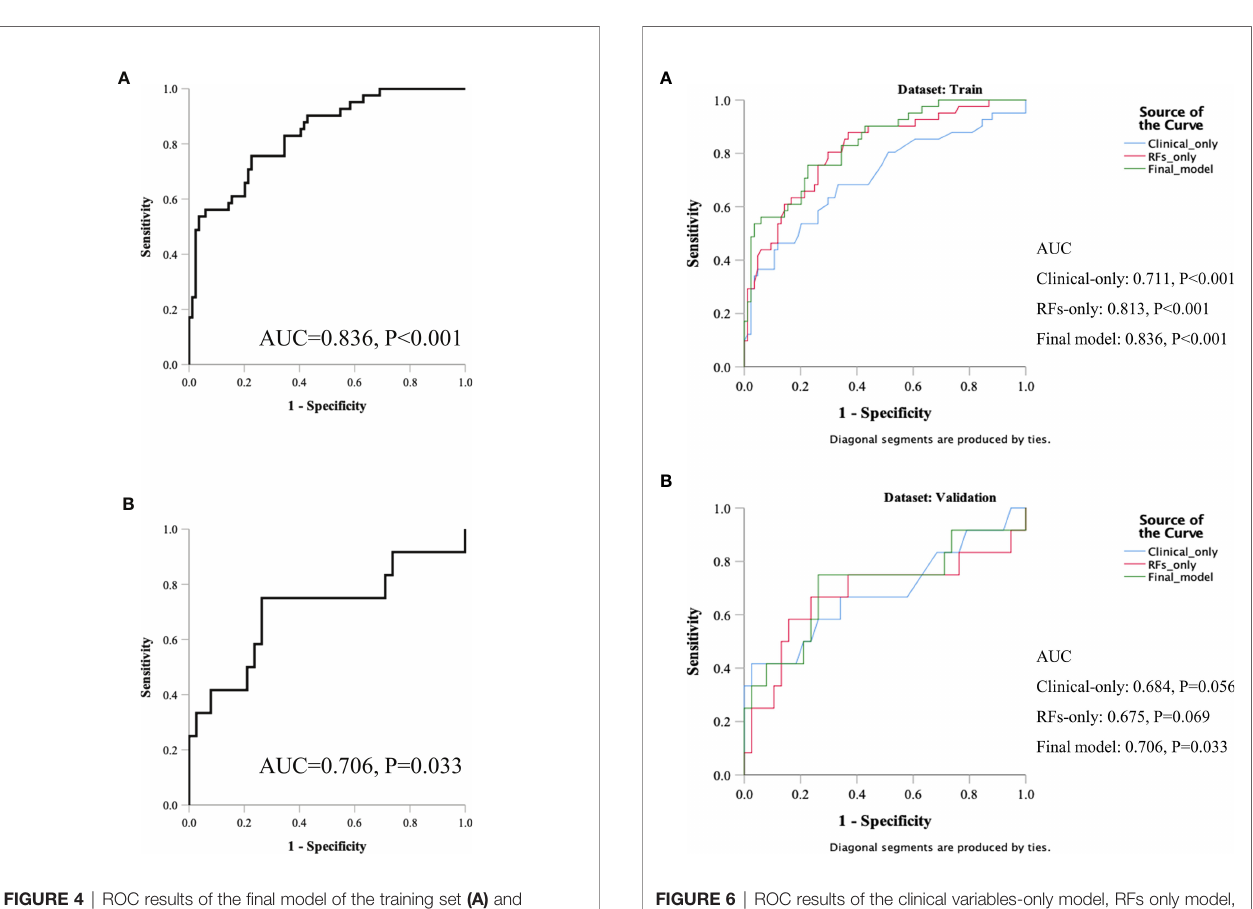
FIGURE 6 | ROC results of the clinical variables-only model, RFs only model, and fi nal model of the training set (A) and validation set (B)